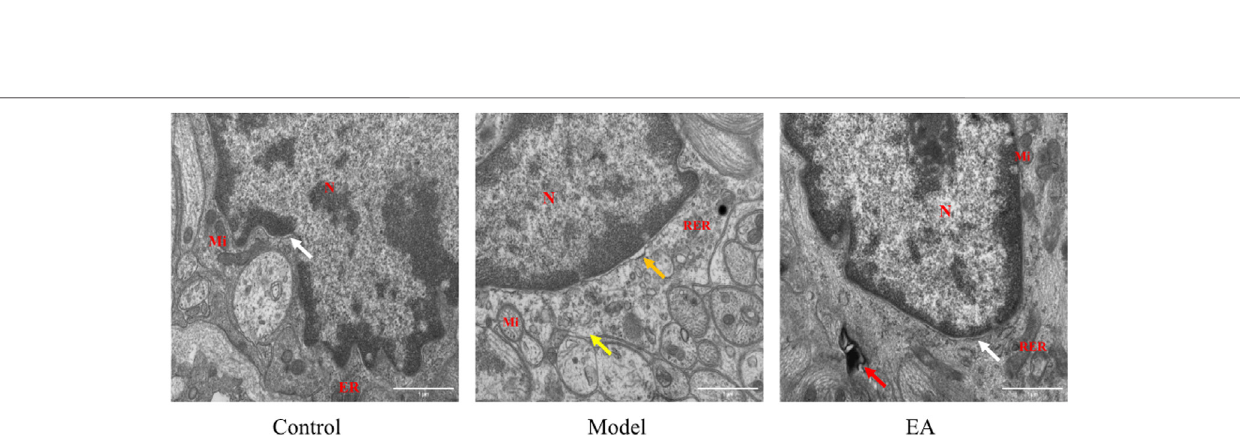
Frontiers in Physiology |